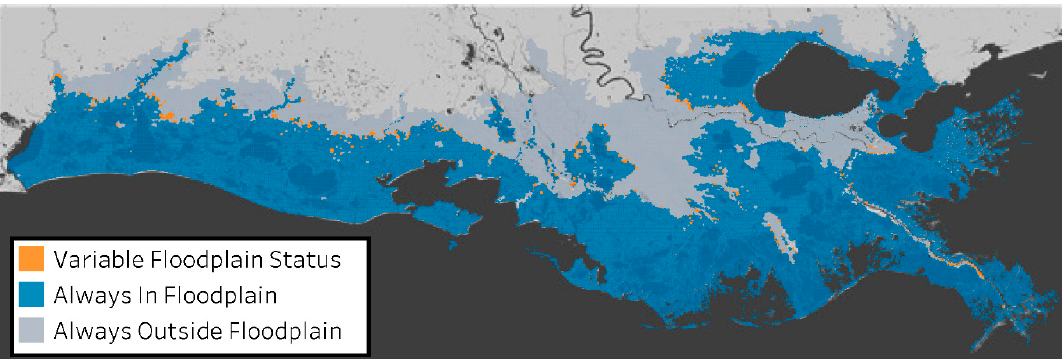
Figure 5. Variability in 100-year floodplain classification, 1980 to 2016.